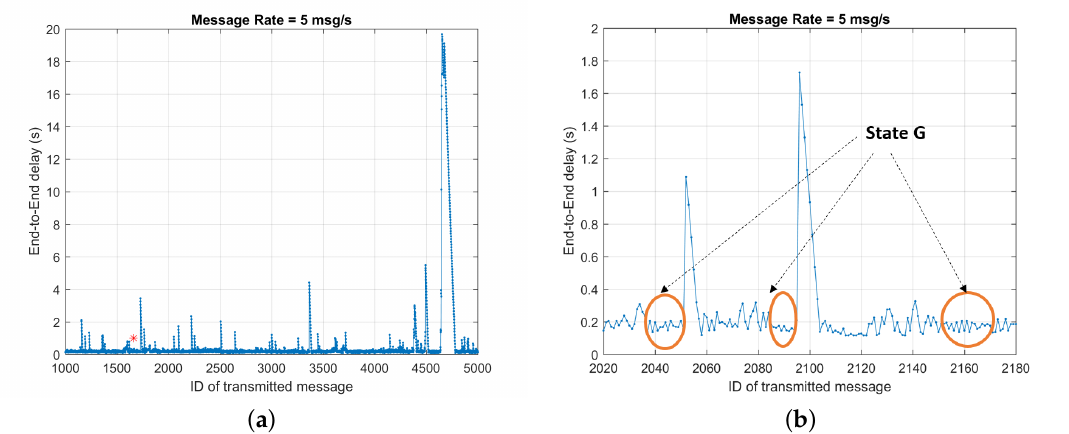
Figure 4. E2E delay as a function of the message IDs. Each message is 500 bytes long; messages are generated at a constant rate of 5 msg/s i.e., one message every 200 ms.